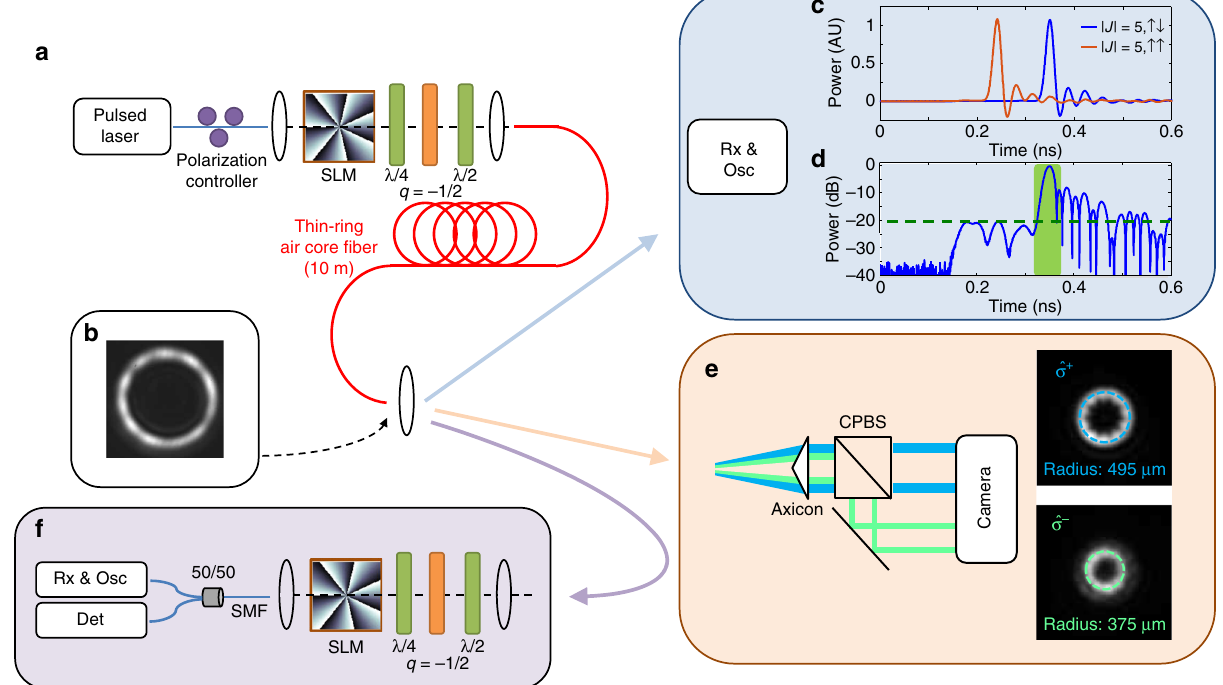
Fig. 3 Experimental apparatus for mode excitation and characterization. a Experimental apparatus for excitation and characterization of angular momentum fi ber modes. b Near fi eld image of the fi ber under test with a pure |J| = 5 , ↑↓ mode excited. c Two independent time of fl ight measurements showing selective excitation of SOI pairs |J| = 5 , ↑↑ and | J| = 5 , ↑↓ , and d time of fl ight measurement of | J | = 5 , ↑↓ on log scale, showing 20 dB + suppression of the SOI pair. e Measurement of the far fi eld of the | J | = 5 , ↑↓ mode from ( d ) after splitting in polarization and propagating through an axicon, which converts angles to position. Two different ring sizes, corresponding to different free space OAM states, are observed as expected. f Reciprocal setup for transmission matrix